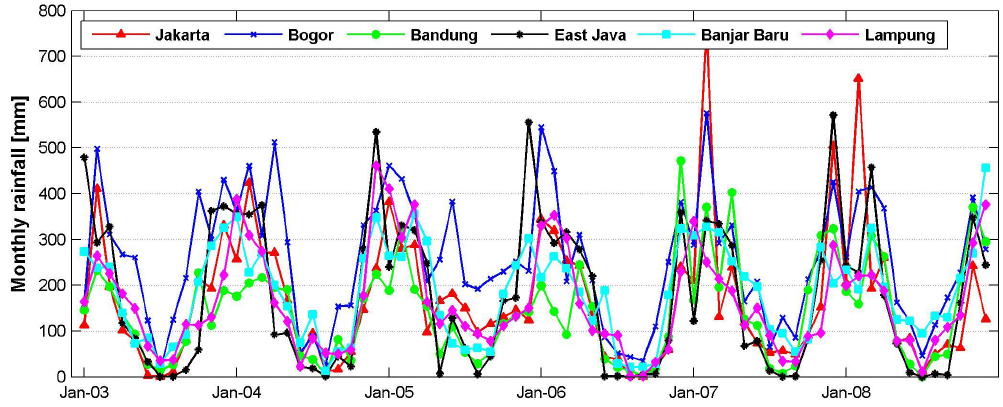
Fig. 3. Average monthly ground station rainfall for the six validation areas for the period 2003–2008. Table 2. Average annual precipitation ( P , in mm) and relative bias (%) over the period 2003–2008 for ground stations, and satellite products TMPA 3B42RT, CMORPH and